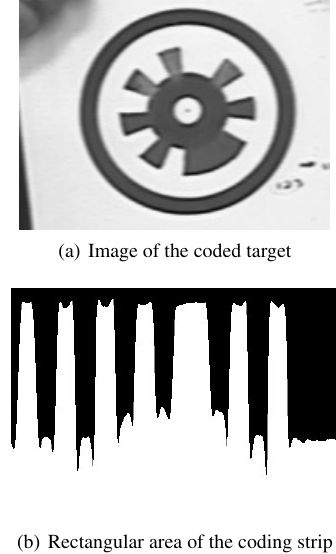
The invariants I 1 , I 1 , I 3 are used for verifying if the detected region is an ellipse.